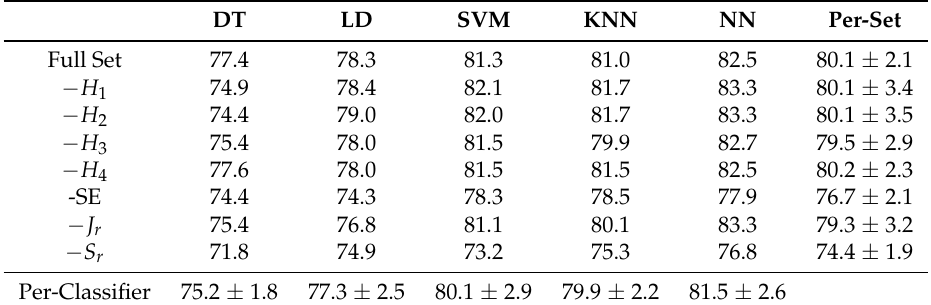
Table 2. Overall classification accuracies (%) for the full set and the LOFO